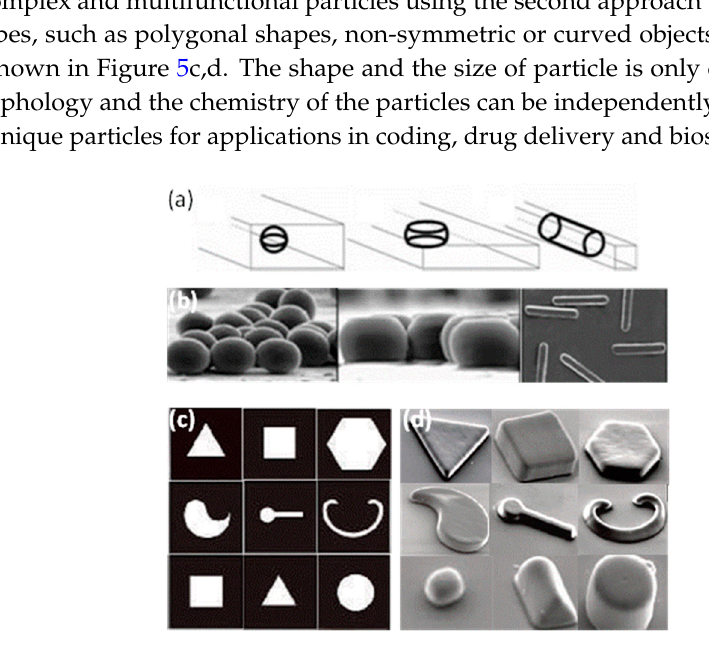
Figure 5. Non-spherical particles formed using the two approaches. ( a ) The spherical droplets deformed by the confinement of the outlet channel; ( b ) The optical microscopy images of particles: ellipsoids, disks, rods with ( a ) approaches [49]. Reproduced with permission from Xu, S., et al., Angewandte Chemie ; published by John Wiley and Sons, 2005; ( c ) The transparency mask used to make nonspherical particles; ( d ) The SEM images of corresponding particles with ( c ) approaches [103]. Reproduced with permission from Dendukuri, D., et al., Nature Materials ; published by Nature Publishing Group, 2006.